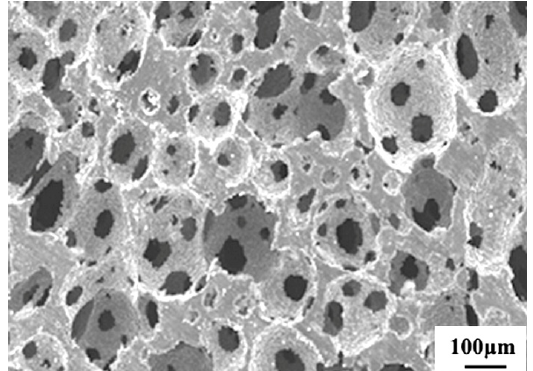
Figure 31. SEM microstructures of porous titanium fabricated by slurry foaming